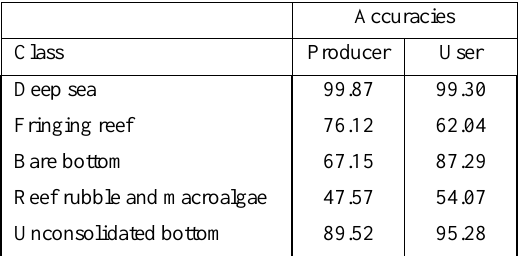
Table 1. Margin settings for A4 size paper